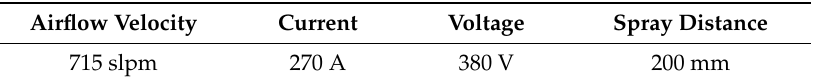
Table 2. Deposition parameters of CoNiCrAlY sprayed using the SSPS